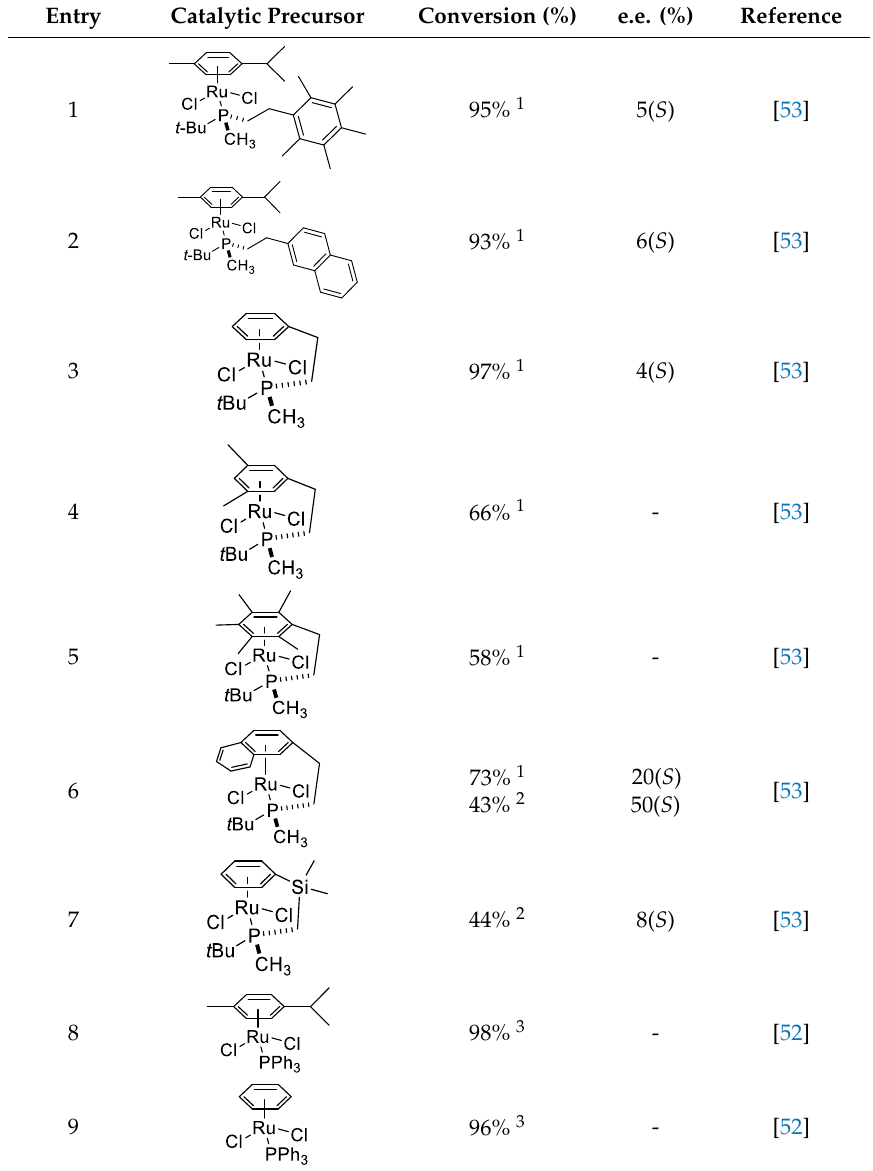
Table 1. Acetophenone reduction thorough Transfer Hydrogenation catalyzed by [RuCl 2 ( η 6 -arene)(P)] complexes in the presence of 2-propanol. Selected examples.